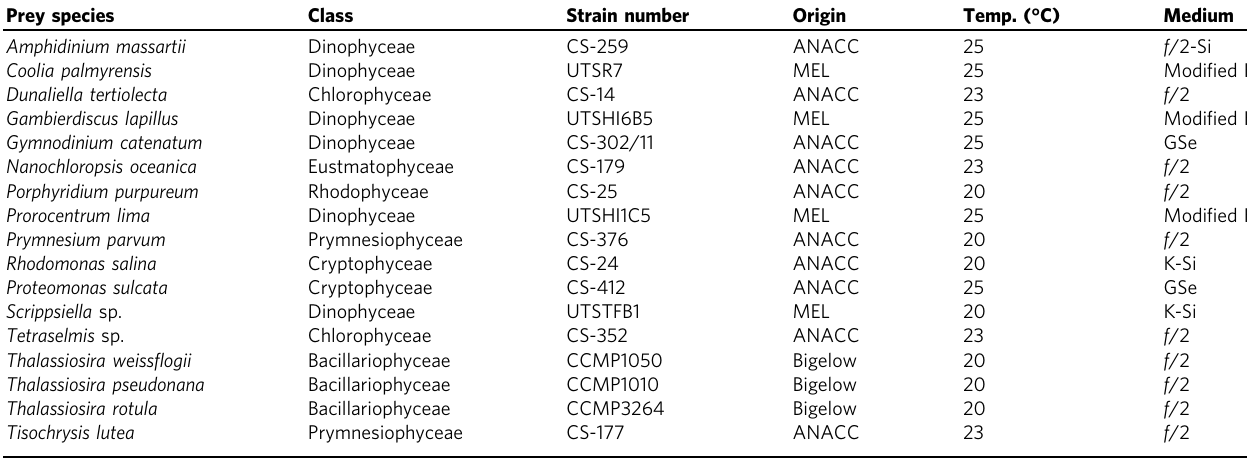
Table 1 Details of the unicellular eukaryotic prey species used in this study and their maintenance conditions. Prey